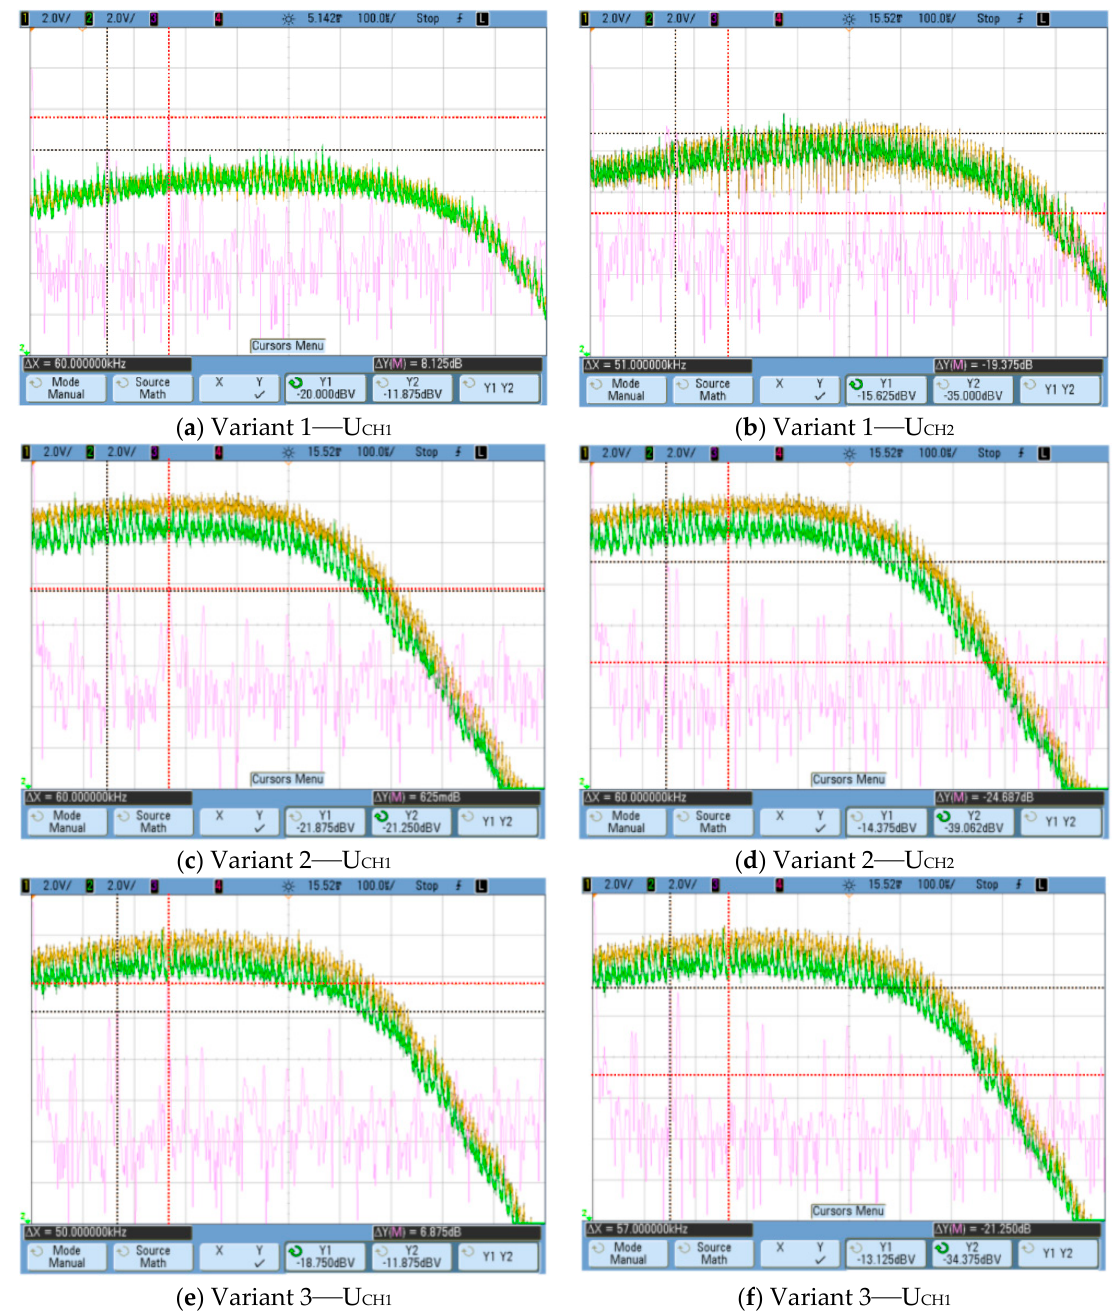
Figure 16. Voltage waveforms and voltage harmonics spectra for the various configurations of the system with the developed filter (X: 50 kHz/div and Y: 10 dB/div). System status: T PLC : broadcast ON; R PLC : ON, measured/analyzed voltages U CH1 and U CH2 ; measured frequency signal level f 1 is the intersection of the black lines and the measured frequency signal level f 2 is the intersection of the red lines.